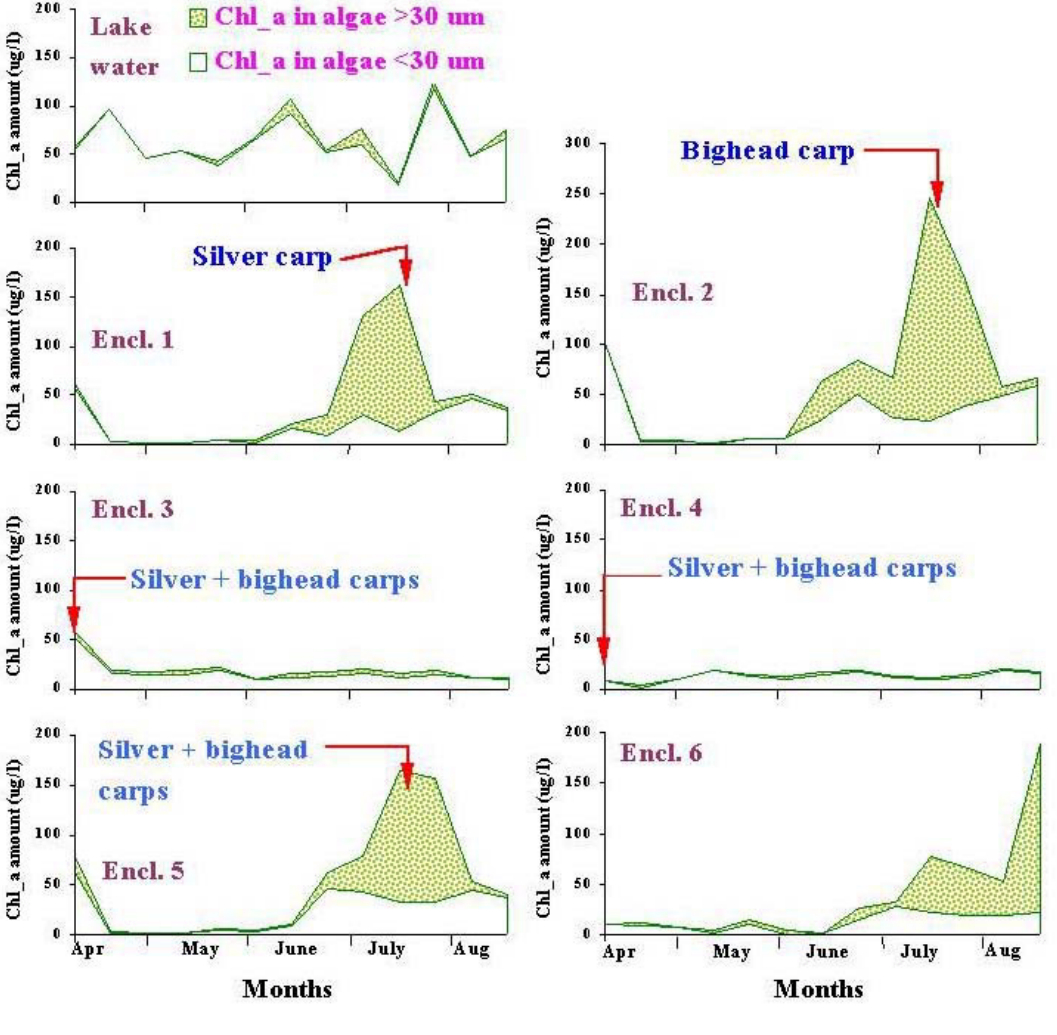
FIGURE 10. Changes in chlorophyll a amount in both total phytoplankton and those <30 µ m phytoplankton in enclosures and the surrounding lake water in Lake Donghu during April-August, 1990 (adapted from Xie and